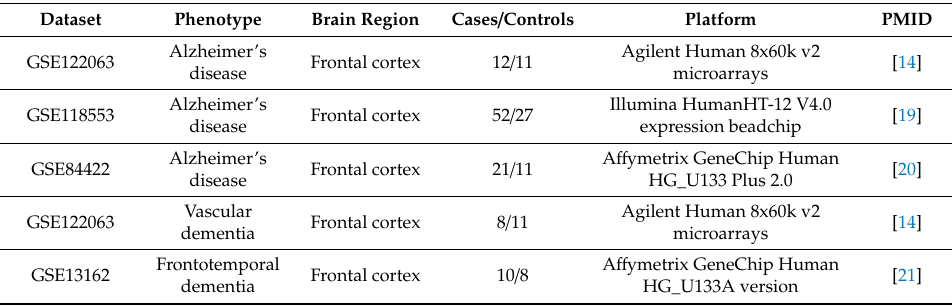
Figure 1. Flowchart of the study. Array Express, NCBI GEO and BSCE databases were searched for frontal cortex transcriptomic studies with data from AD, VaD and FTD patients. Microarrays were analyzed using the SWIM algorithm to identify switch genes. Pathway and transcription factor analyses of switch genes were performed using NetworkAnalyst. Table 1. Gene expression datasets selected in this study.